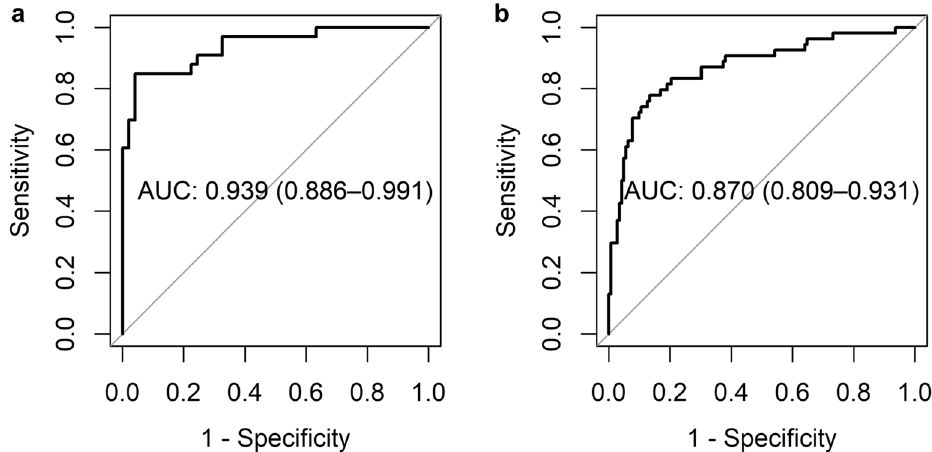
Figure 3. Performance of our model for detecting EBV + MSI/dMMR. ROC curves and AUCs (95%CI) are shown for UTokyo test cases ( a ) and TCGA test cases ( b ). This shows the performance of the model trained with data augmentation and the addition of a part of TCGA cases as training data. AUC- Area under the curve, CI- confidence interval, EBV- Epstein-Barr virus, MSI- microsatellite instability, dMMR- mismatch repair